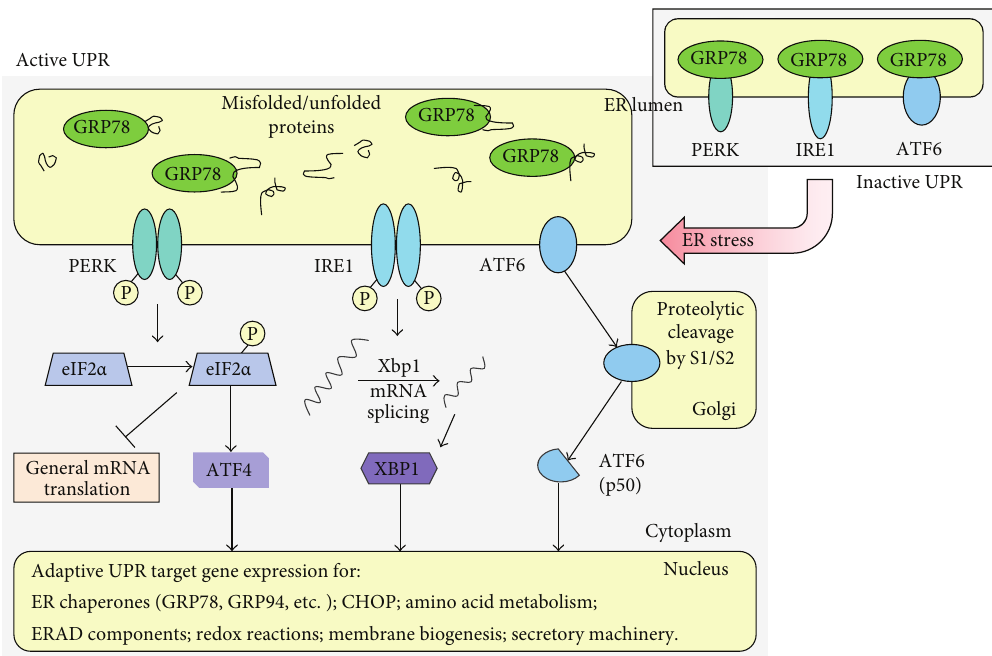
F 2: Overview of the three signaling branches of the ER stress response/UPR. In the absence of ER stress, ER luminal GRP78 associates with ER transmembrane proteins PERK, IRE1, and ATF6 to block their activation (shown as inactive UPR in the top right square). Upon ER stress, accumulating unfolded and misfolded proteins inside the ER sequester GRP78, thus dissociating this master regulator from all three transmembrane sensors and relieving their blockage. Activation of PERK entails homodimerization and autophosphorylation, leading to phosphorylation of eIF2 , which terminates global protein translation, but exempts selected ER stress-associated proteins, such as ATF4. Activation of IRE1 also entails homodimerization and autophosphorylation. Endonuclease activity of activated IRE1 removes an intron from Xbp1 mRNA to generate a shorter splice variant that encodes transcription factor XBP1. ATF6 translocates to the Golgi, where it is 𝛼𝛼 proteolytically cleaved by S1 and S2 proteases to generate the transcriptionally active p50 fragment. All three transcription factors, ATF4, XBP1, and ATF6-p50 translocate into the nucleus where they regulate the expression of a variety of gene products collectively involved in managing ER stress. (See text for further details and